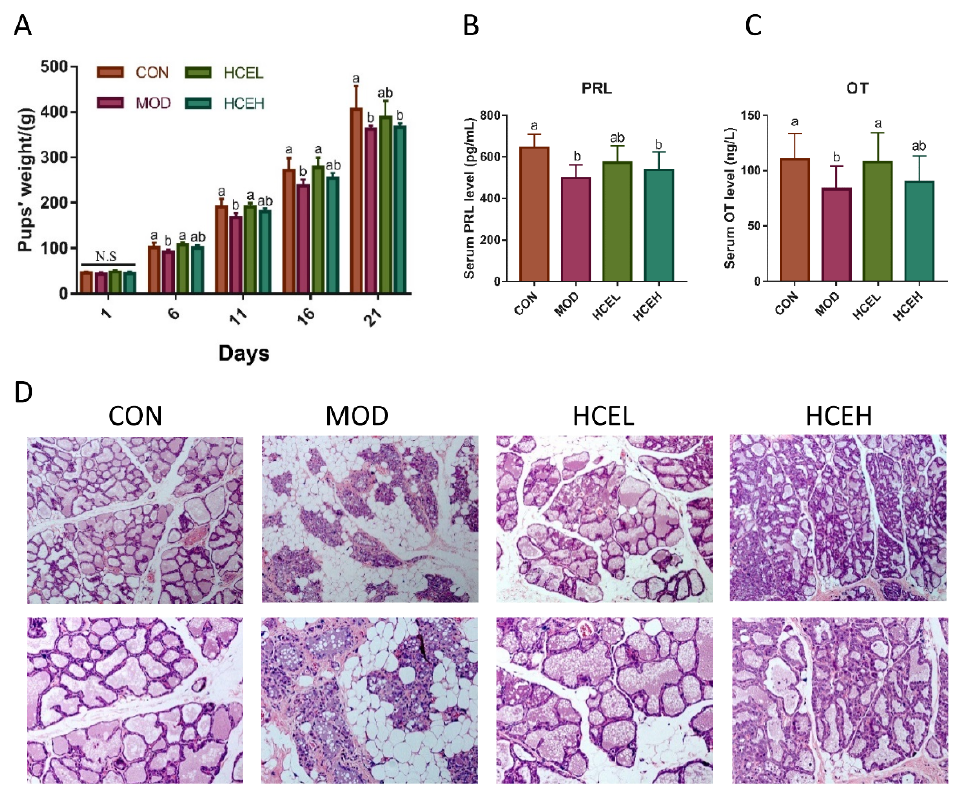
Figure 1. Effects of HCE on lactation of CUMS dams. ( A ) Pups’ weight change during the lactation. ( B ) Serum PRL level of female rats among four groups. ( C ) Serum OT level of female rats among four groups. ( D ) Histopathological analysis of the mammary gland sections of rats in different groups at 10× and 20× magnification. For images A–C, different letters indicate a significant difference between columns, p < 0.05. CON: the control group (n = 8); MOD: the chronic unpredictable mild stress group (n = 8); HCEL: the HCE low dose group (n = 8); HCEH: the HCE high dose group (n = 8).